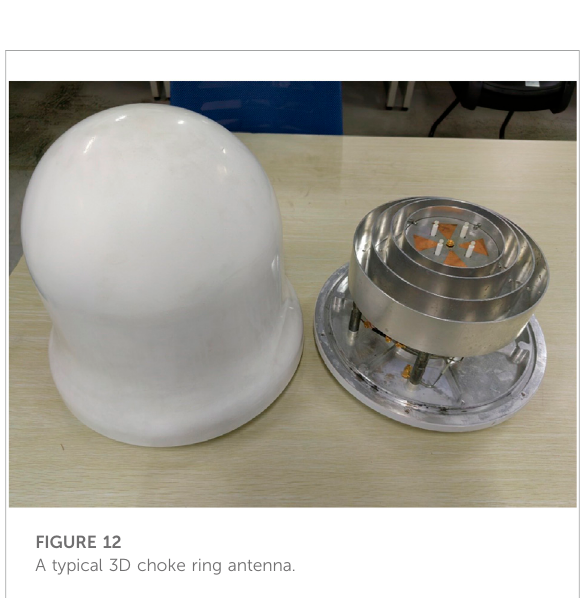
FIGURE 12 A typical 3D choke ring